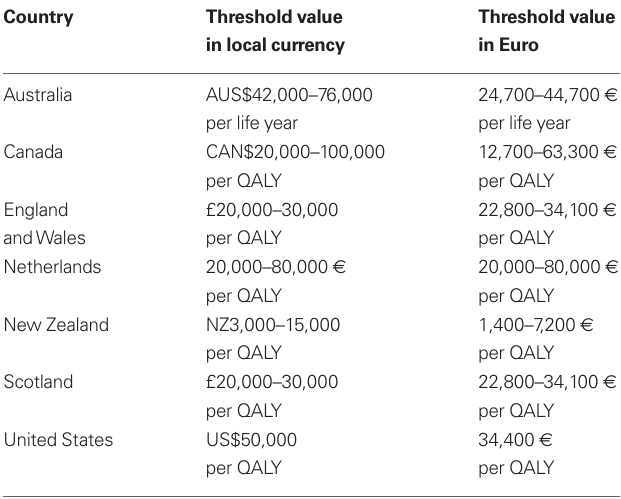
Table 2 | Threshold iCer values in a selection of